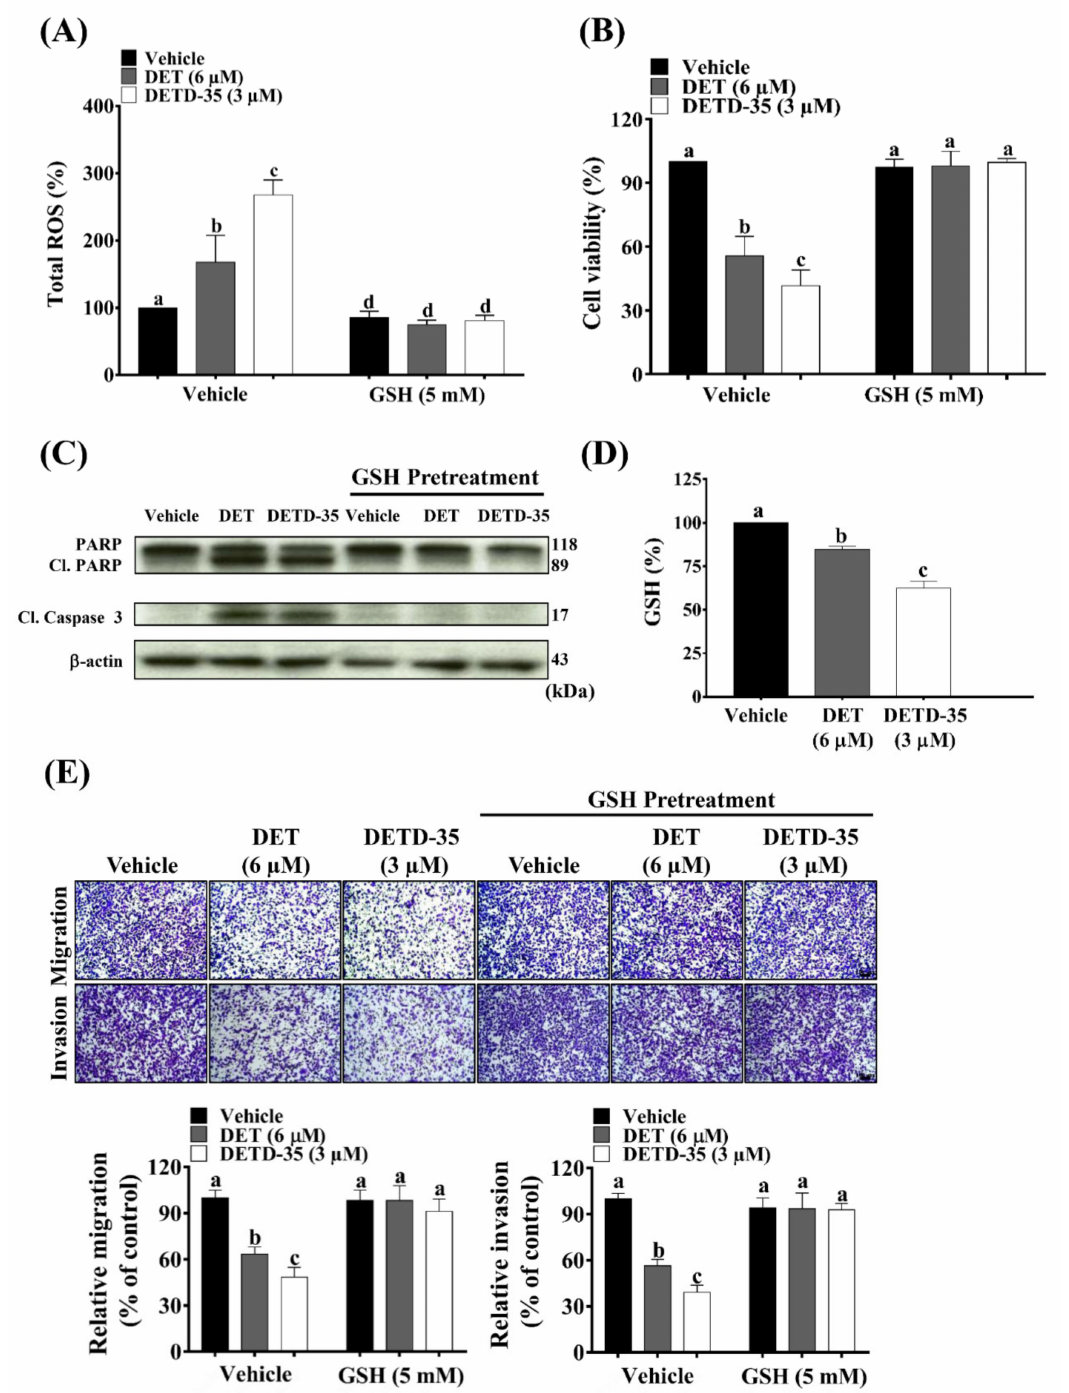
Figure 4. GSH reversed DET- and DETD-35-induced oxidative-stress mediated anti-proliferative and metastatic bioactivities in A375LM5 IF4g/Luc cells. ( A ) A375LM5 IF4g/Luc melanoma cells were pre-treated with/without ROS scavenger GSH (5 mM) for one hour and then incubated with vehicle, DET, or DETD-35 for one hour together with a green probe that can be oxidized to a green fluorescence product upon reaction with ROS. Intracellular fluorescence was measured by flow cytometry. Data are mean ± SD, n = 3. ( B ) A375LM5 IF4g/Luc melanoma cells were pre-treated with/without GSH (5 mM) for one hour and then incubated with vehicle, DET, or DETD-35, and the cell viability was determined by MTT assay 24 h later. Data are mean ± SD, n = 3. ( C ) The A375LM5 IF4g/Luc cells were pre-treated with/without GSH (5 mM) for one hour and then incubated with vehicle, DET (6 µ M) or DETD-35 (3 µ M) for 48 h, and expression levels of apoptotic protein